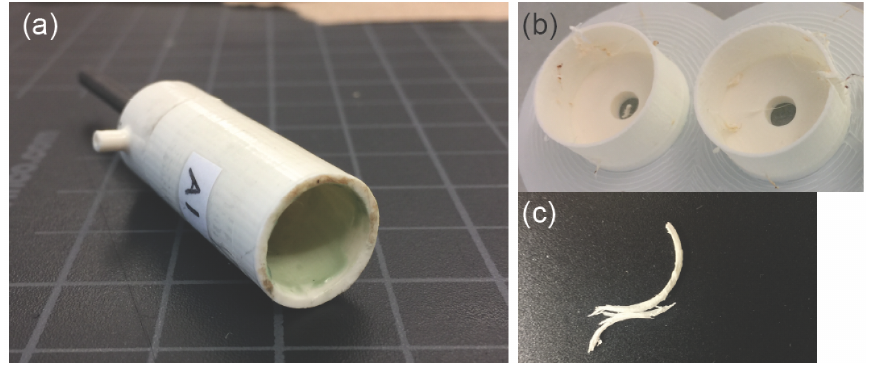
Figure 4. ( a ) A cross-section view of the the actuator cylinder post acetone treatment, ( b ) a failed print of the cylinder, ( c ) a ring from the cross-section from a failed print of a